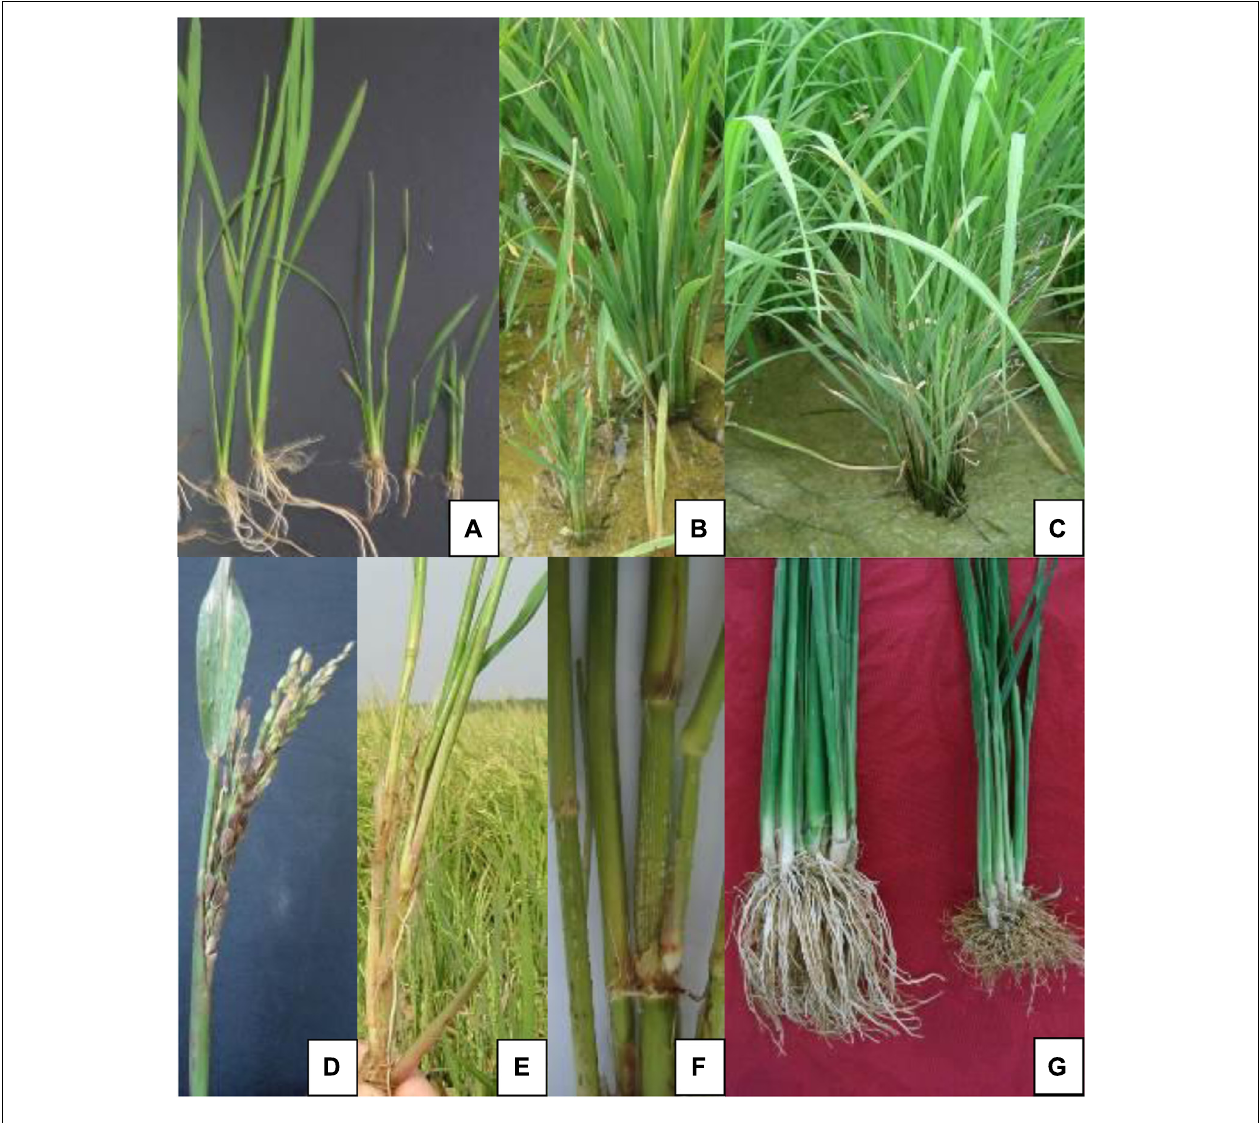
tillering. (D) Diseased head showing small spikes and barren grains. (E) Aerial rootlets and branches on the stem nodes of an infected plant. (F) Small streaked white or black waxy galls on the stems of an infected plant. (G) Poorly developed brown roots (right) of an infected